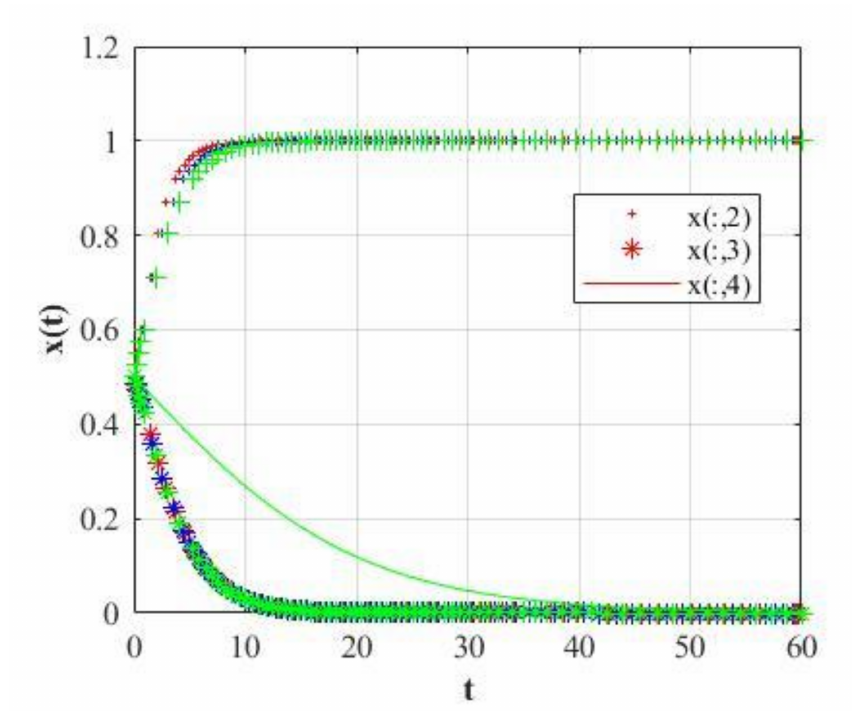
Figure 15. Change the parameter δ 2 = 0.2 (red curve), 0.6 ((blue curve), 0.9 (green curve) to take the value of the three-way strategy evolution